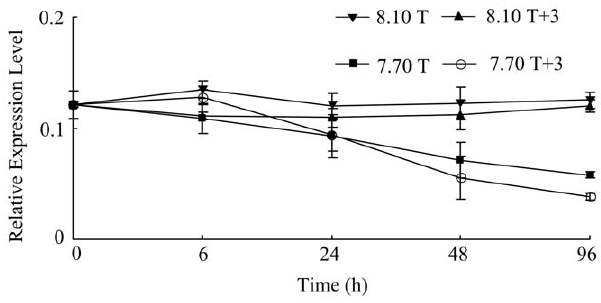
Figure 3. Real-time PCR analysis of expression of nacrein in response to elevated temperature and declined pH.